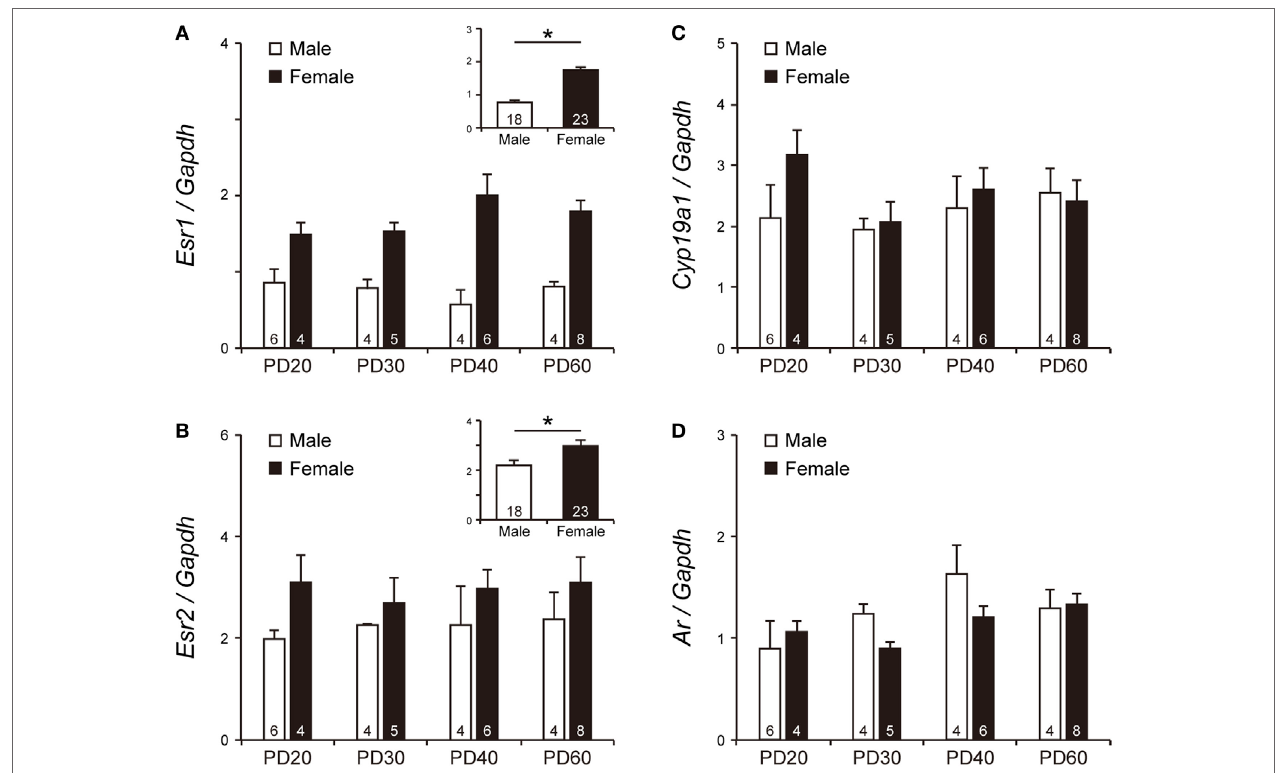
FigUre 4 | The mRNA levels of Esr1 , Esr2 , Cyp19a1 , and Ar in the BNSTp of peripubertal mice. The mRNA levels of Esr1 (a) , Esr2 (B) , Cyp19a1 (c) , and Ar (D) in male and female mice on PD20, PD30, PD40 and PD60. The inset graphs in panels (a,B) indicate the average mRNA level of Esr1 and Esr2 in all ages, respectively. The numbers in the columns indicate the numbers of animals. Values are the mean ± SEM. * p <